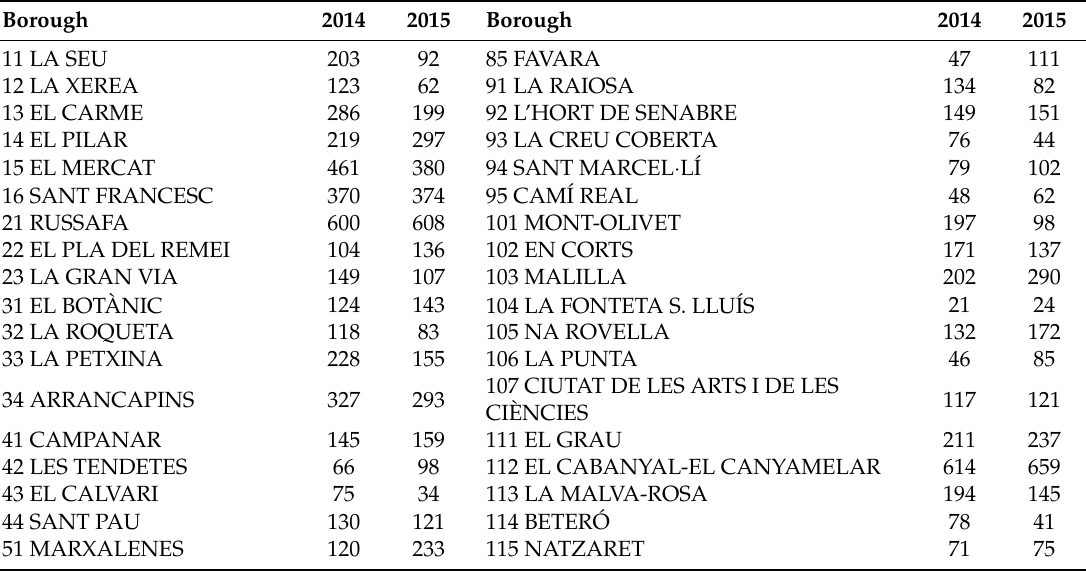
Table A1. Yearly noise incidents per